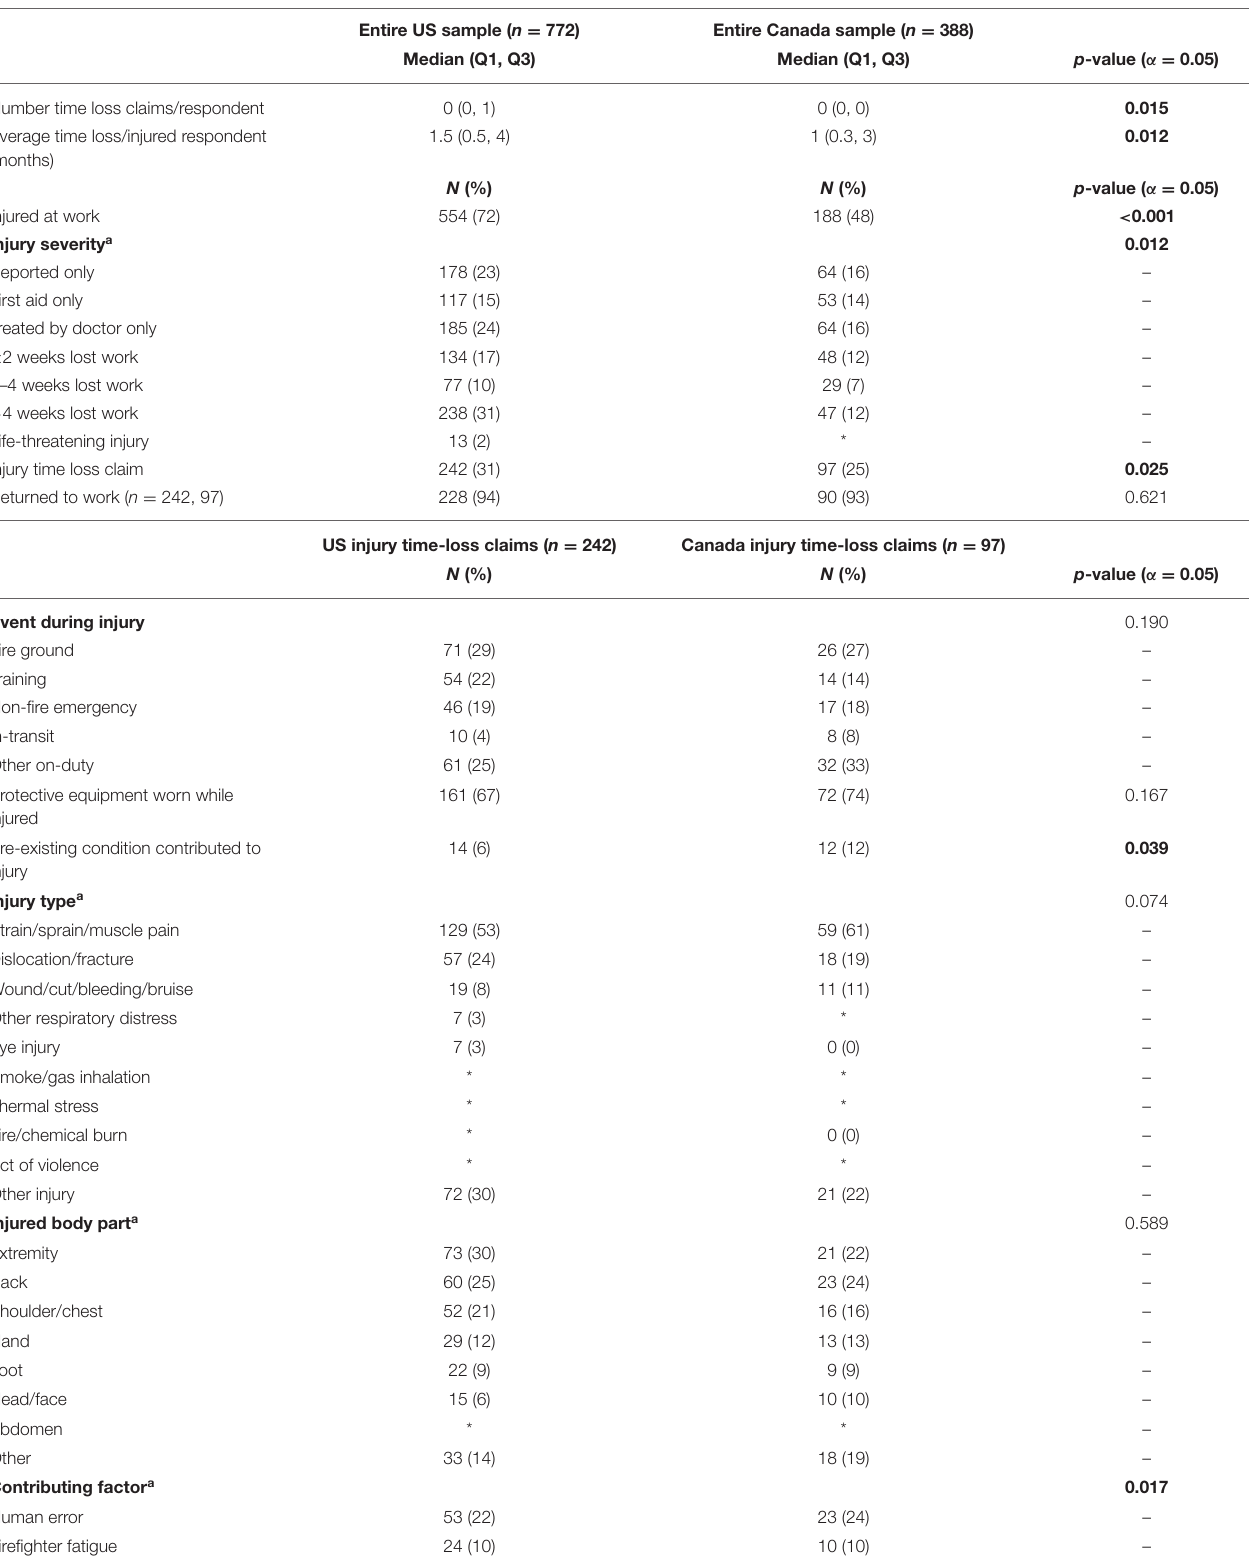
TABLE 5 | Characteristics of work-related injuries among active female firefighters in the US and Canada, by